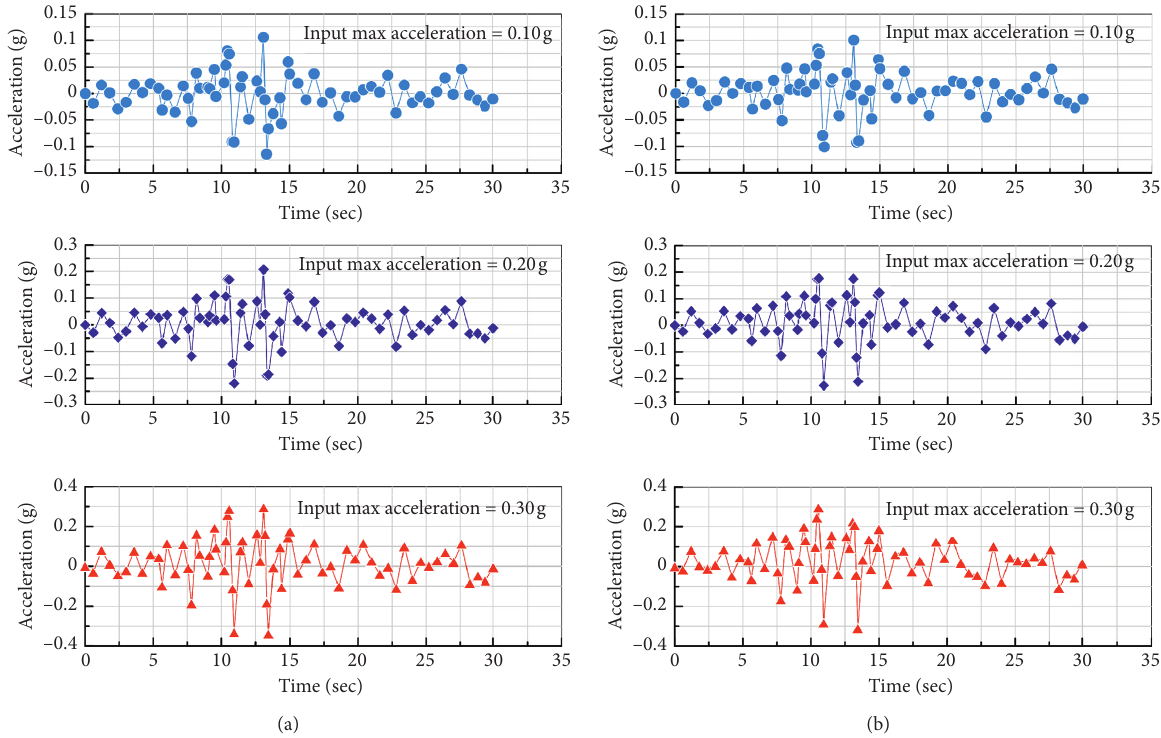
Figure 12: Time-course curves of acceleration of the third subdam and ash storage field under three input earthquakes ( L Third subdam. (b) Ash storage